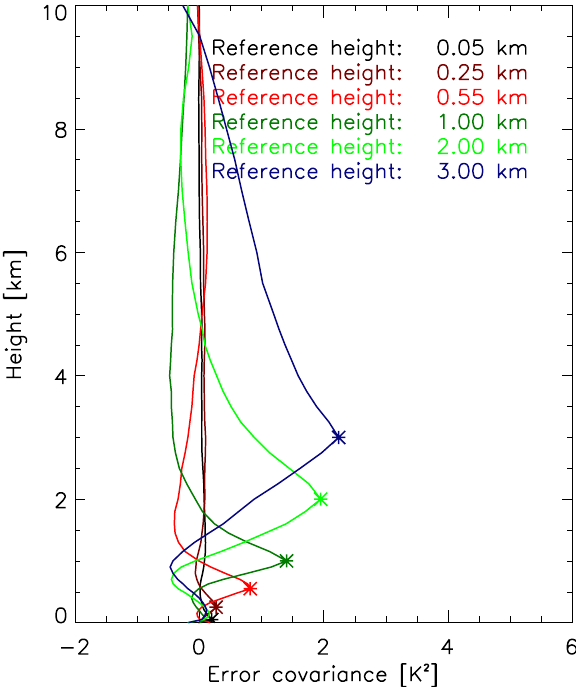
Fig. 10. Temperature error covariances calculated from all-sky con- Figure 10 : Temperature error covariances calculated from all-sky conditions from August 2006 – 685 ditions from August 2006–December 2009 between MWR and ra- diosonde measurements. The error covariances are shown for six December 2009 between MWR and radiosonde measurements. The error covariances are shown for 686 specific height levels. Asterisks show the reference six specific height levels. Asterisks show the reference heights. 687